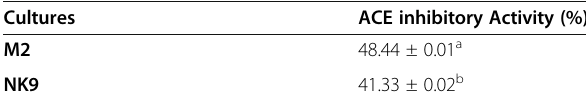
Table 4 ACE inhibitory activity of the soy milk fermented with L. fermentum M2 and L. casei NK9